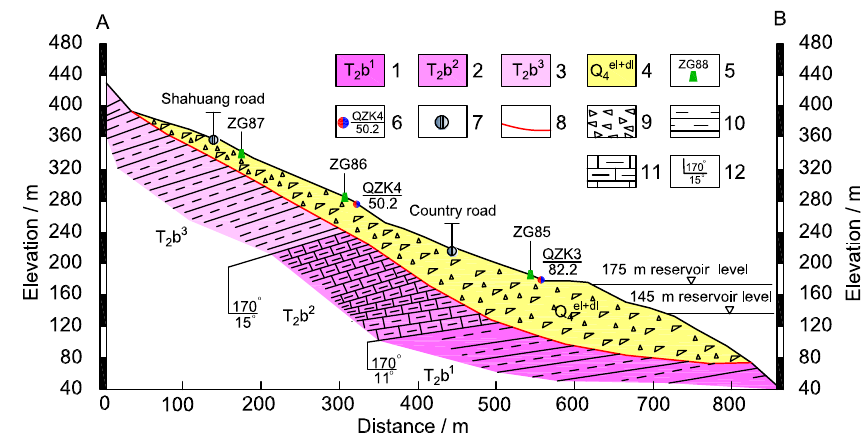
Figure 5. Geological longitudinal section (line A–B in Fig. 4) of Shuping landslide. (1) Middle Triassic Badong formation section; (1, 2) Middle Triassic Badong formation section; (2, 3) Middle Triassic Badong formation section; (3, 4) Quaternary colluviums; (5) GPS monitoring stations and number; (6) inclinometer monitoring hole and its depth (the unit of depth is the meter); (7) roads; (8) sliding zone;